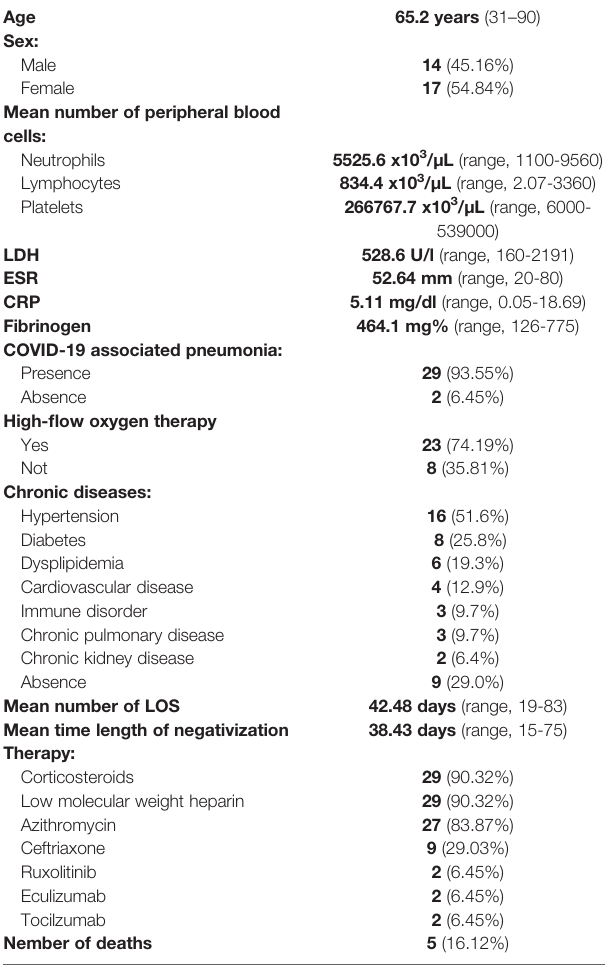
patients. Speci fi cally female patients displayed higher levels of sPD-L1 as compared to males (p=0.0472) ( Figure 1D ). Older patients displayed a higher level of sPD-L1 as compared to that of ( Figure 2D ). More importantly serum levels of sPD-L1 signi fi cantly correlated with the prognosis of COVID-19 patients (p=0.0469). Speci fi cally, levels of PD-L1 were higher in all those patients who later died during the hospitalization (mean 0.227, range 0.111-0.402) as compared to patients who were Patients with high levels of PD-L1 were characterized by old age (p=0.0067) ( Figure 3B ), low number of lymphocytes ( Figure 3D ), high levels of LDH (p=0.0154) ( Figure 3E ), high LOS (p=0.0417) ( Figure 3F ) and high number of deaths (p=0.048). Noteworthy no correlations between serum levels of sPD-L1 with patient comorbidities as well as with patient therapies ( Supplementary Tables 1 and 2